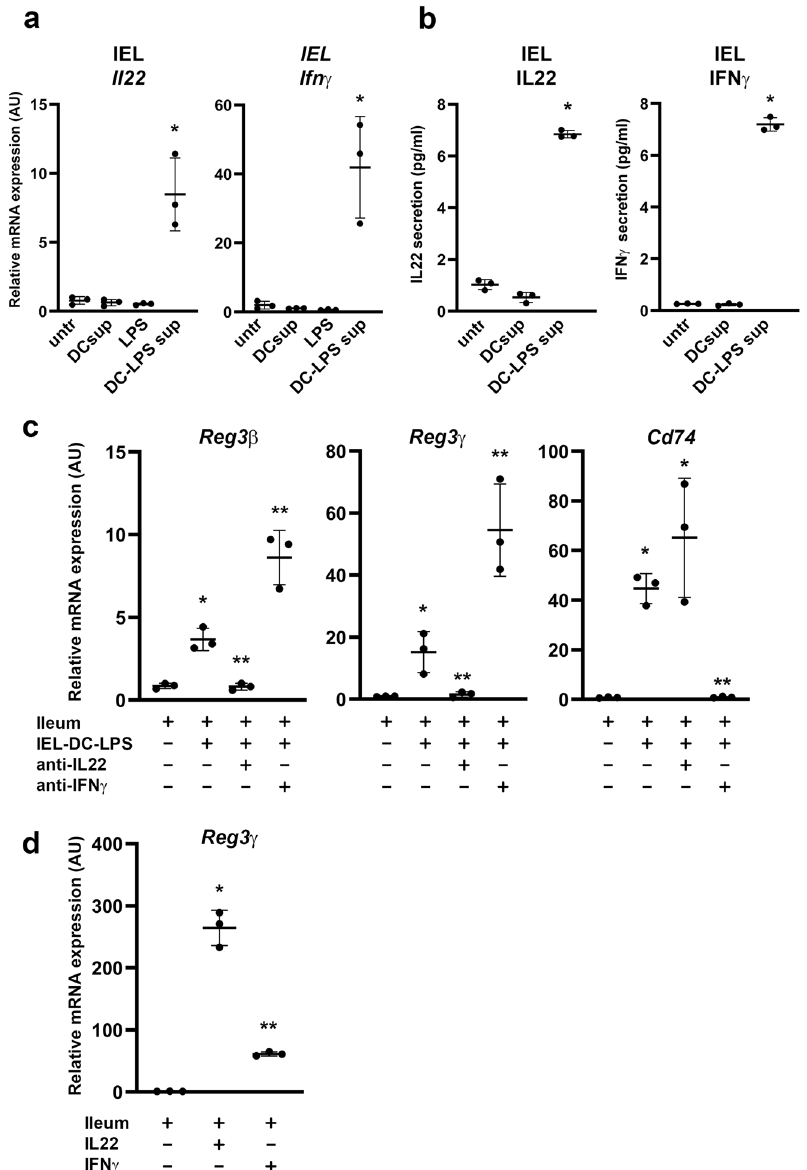
Fig. 3 Reg3 γ expression in intestinal organoids is induced by IEL-derived IL22 or IFN γ . a Il22 and Ifn γ mRNA expression in intestinal epithelial lymphocytes, freshly isolated from mouse small intestine, and stimulated with supernatants form LPS-treated bone marrow-derived dendritic cells. b Protein secretion by intestinal epithelial lymphocytes, freshly isolated from mouse small intestine, and stimulated with supernatants form LPS-treated bone marrow-derived dendritic cells. c Reg3 β , Reg3 γ , and Cd74 mRNA expression in ileum-derived organoids after 24 h exposure to supernatants from IEL cells with prior exposure to supernatants from LPS-stimulated BMDCs in the presence or absence of blocking antibodies for IL22 or IFN γ . d Reg3 γ mRNA expression in ileum-derived organoids after 24 h exposure to IL22 alone or IL22 combined with IFN γ (5 ng/ml). All experiments were performed in triplicate with a minimum of three independent experiments. All data are shown as mean ± SD. For statistical analyses, Log2 transformed data were used in Welch and Brown – Forsythe tests followed by Dunnett ’ s T3 multiple comparisons test. * P < 0.05 was considered to indicate statistical signi fi cance. ** P < 0.05 compared to stimulated